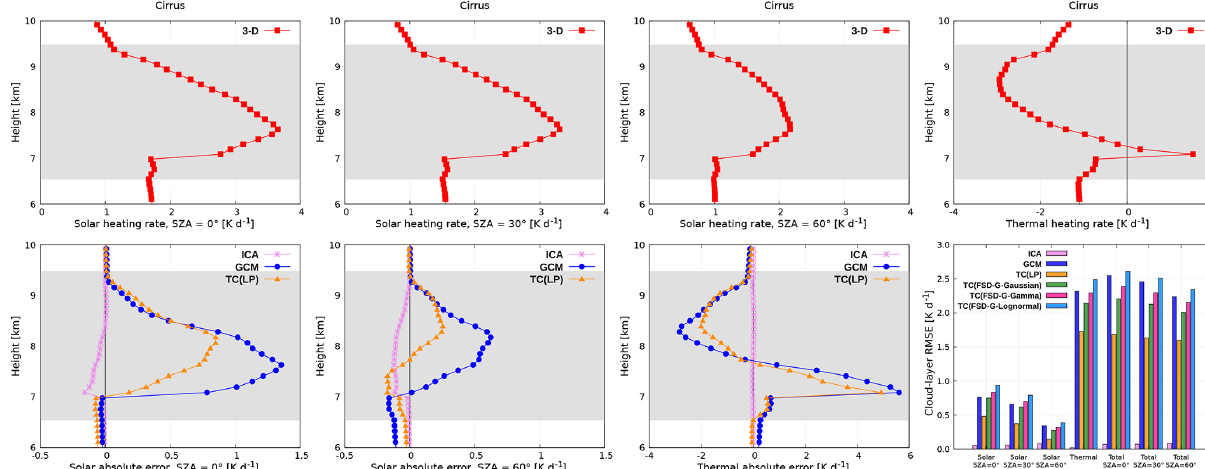
Figure 8. Radiative heating rate for the cirrus cloud. The gray-shaded area denotes the cloud layer.